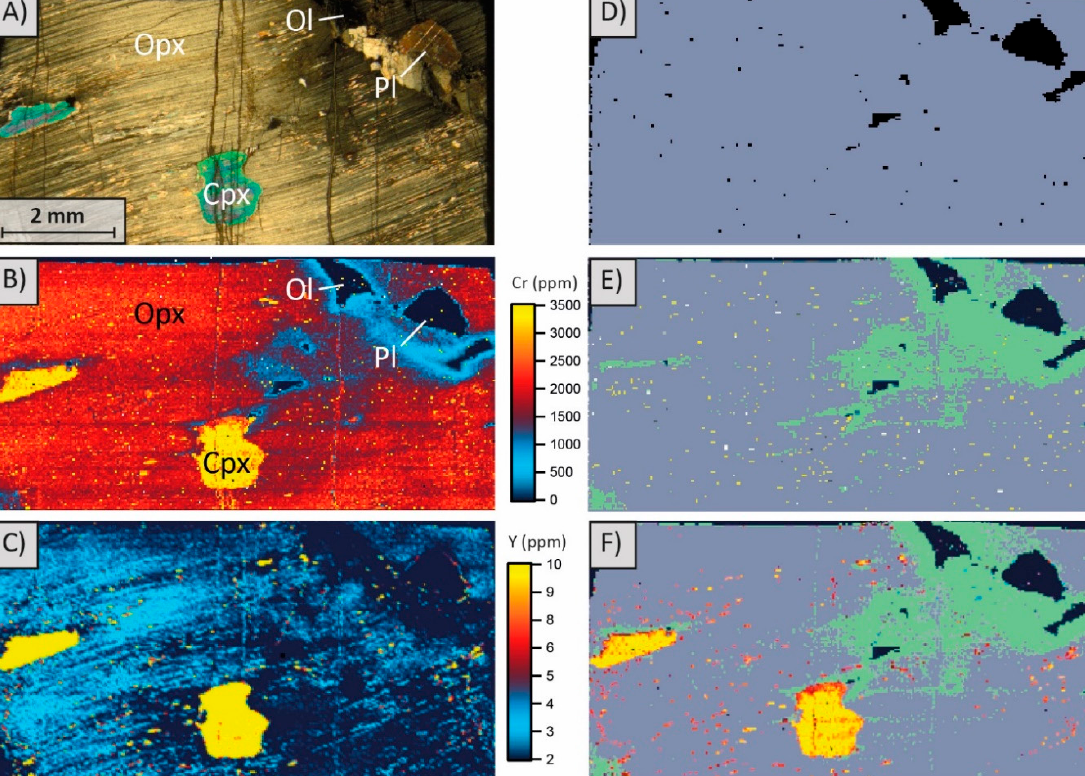
Figure 7. ( A ) Cross polarised microscope image, sample 309.75b, Upper Pegmatoid, Opx (orthopyroxene), Ol (olivine), Pl (plagioclase), Cpx (clinopyroxene); ( B ) semi-quantitative Cr distribution map; ( C ) semi-quantitative Y distribution map; ( D ) grey ROI with criterion: Cr > 100 ppm superimposed on map ( B ); ( E ) green ROI ‘rim’ with criterion: 100 ppm < Cr < 1500 ppm and grey ROI ‘core’ with criterion: Cr > 1500 ppm superimposed on map ( B ); ( F ) green regions of interest (ROI) with criterion: 100 ppm < Cr < 1500 ppm and grey ROI with Criteria: Cr > 1500 ppm, Y < 6 ppm superimposed on map ( B ).